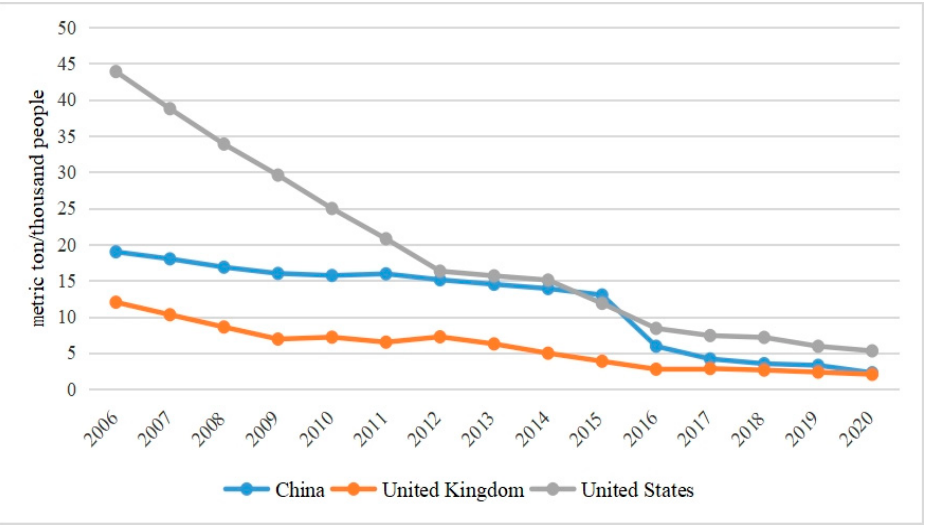
Figure 3. 2006–2020 China, the UK, and the US SO 2 air pollution (SO 2 emission metric ton/thousand people). Data source: ourworldindata.org